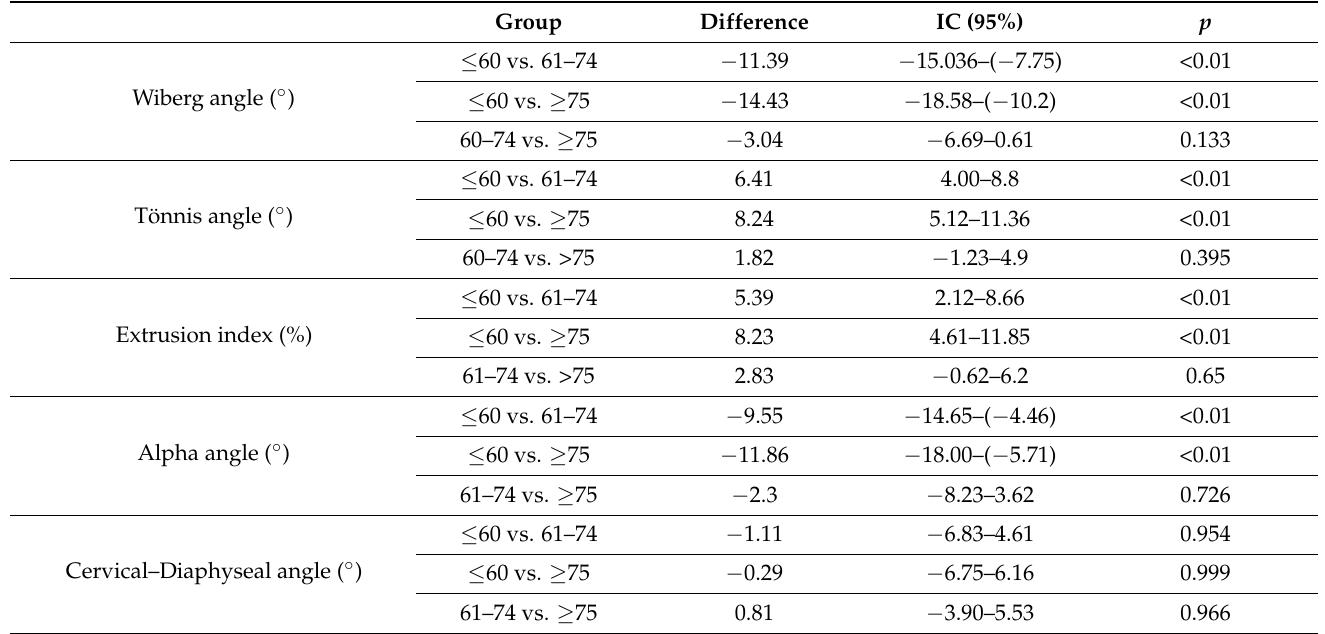
Table 3. Angle comparisons between groups. Group 1, ≤ 60 years old; group 2, 61–74 years old; group 3, ≥ 75 years